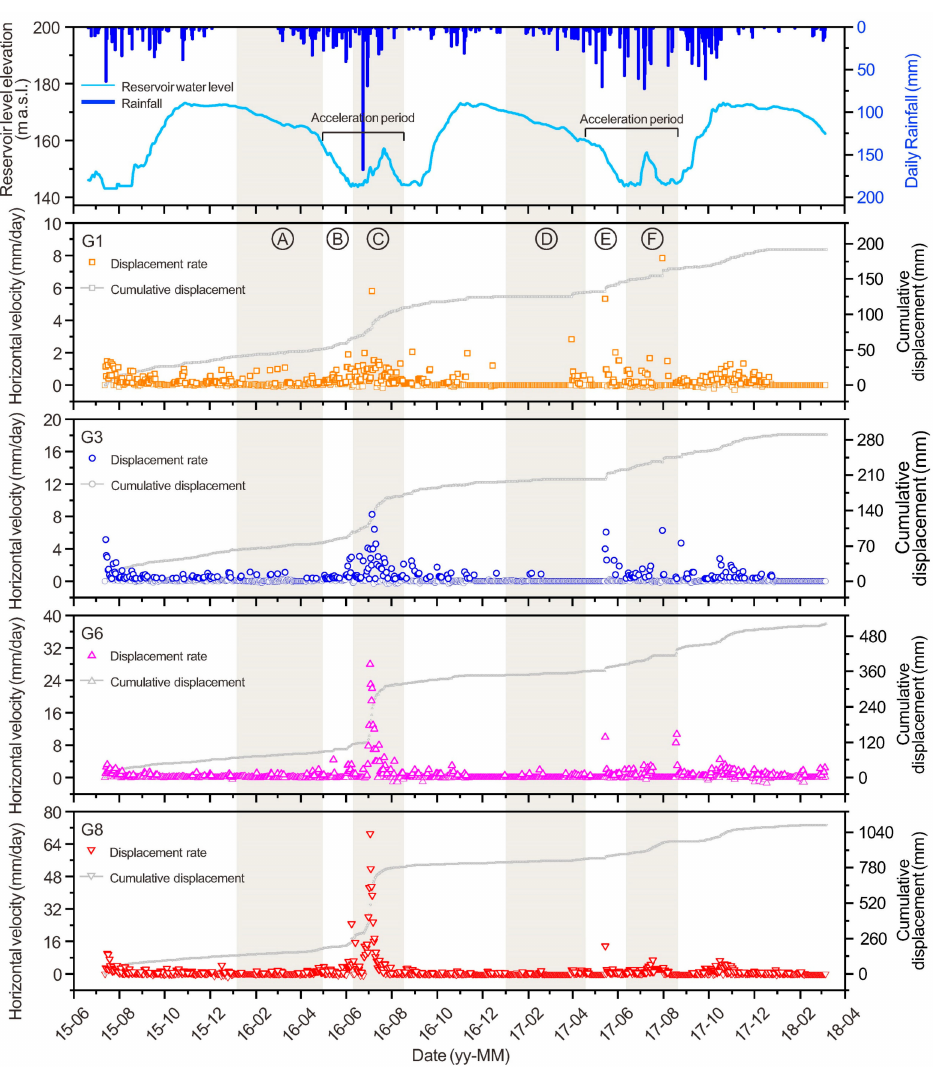
Figure 15. Displacement rate of GNSS points and its relationship with reservoir water level and daily precipitation. A–F represent different time periods in 2016 and 2017. Please see the details in Table